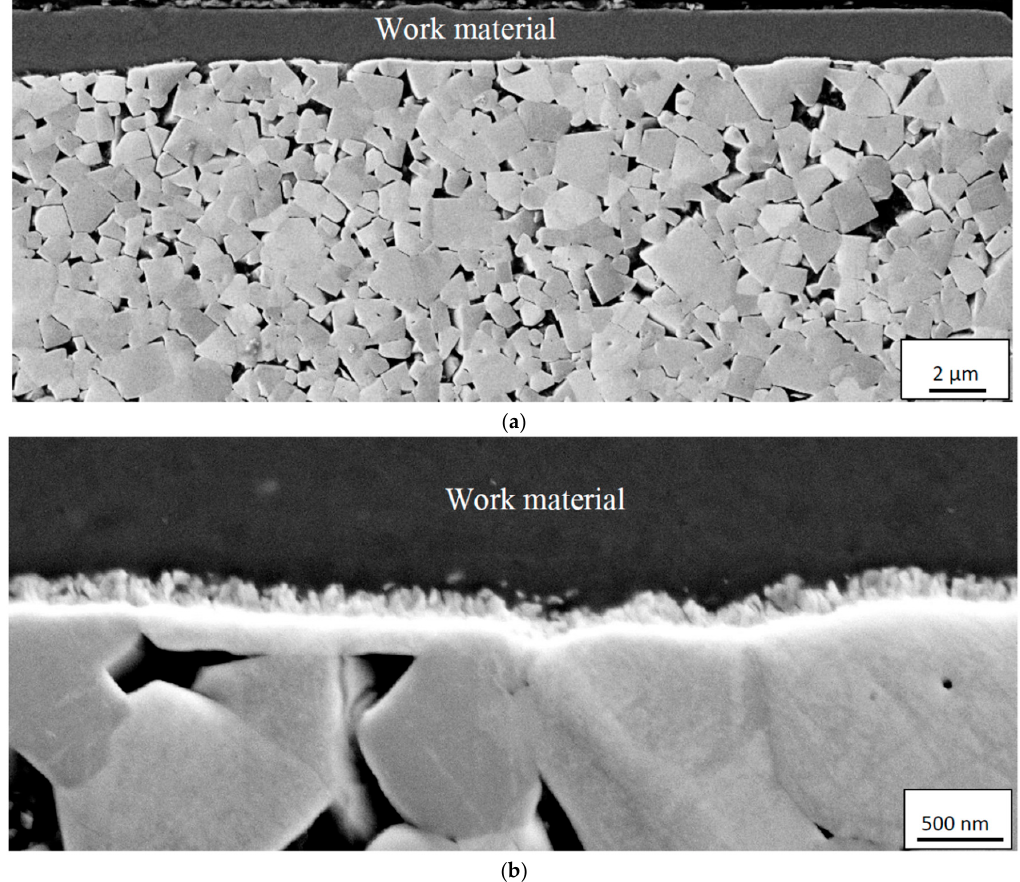
Figure 14. ( a ) Cross-section of the crater showing a smooth cemented carbide surface illustrating the presence of a di ff usion wear mechanism. ( b ) Detail showing the presence of the di ff usion interfacial layer (white) at the cemented carbide / adhered work material interface. Chip sliding direction from right to